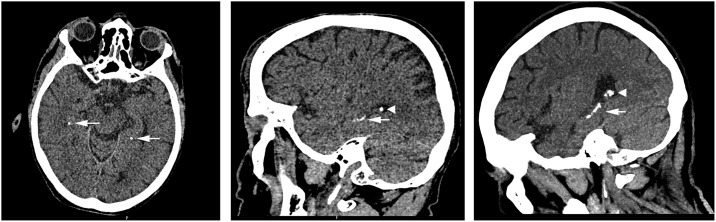
Hippocampal calcification on thin unenhanced CT examinations (arrows).The left axial reconstructed image shows bilateral mild hippocampal calcification (dot). The middle sagittal reconstructed image shows moderate hippocampal calcification (multiple dots). The right sagittal reconstructed image shows severe hippocampal calcification (confluent). Calcification of the choroid plexus is also visible (arrowheads).